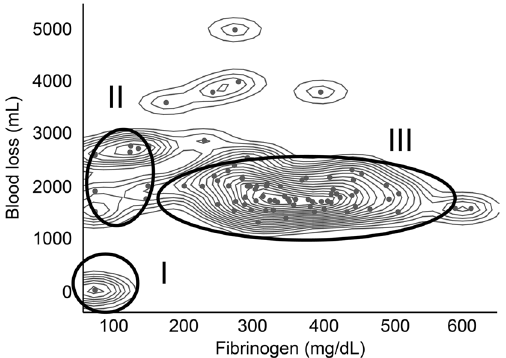
Figure 1. Non-parametric density estimation distribution of the ratio (B/F) of blood loss at onset and blood fibrinogen levels. Of all 87 cases shown, based on blood loss at onset and blood fibrinogen levels, the